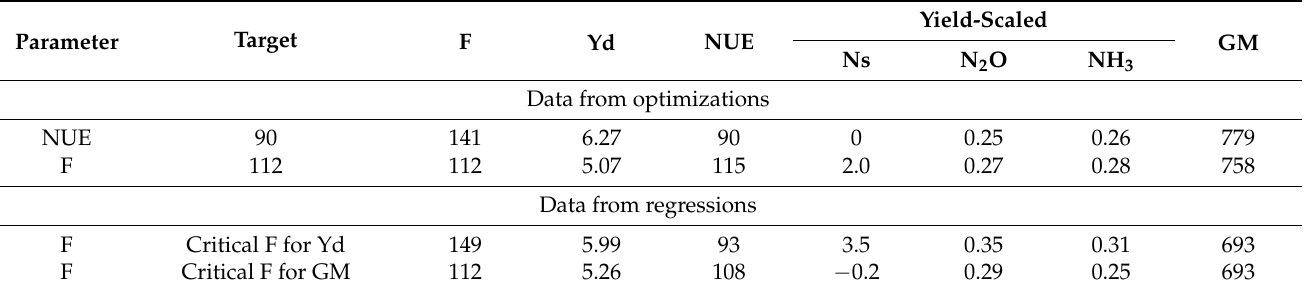
Table 2. Comparison of parameters from optimization and regression analyses; F (kg N · ha − 1 ); Yd (Mg · ha − 1 ); NUE (%);